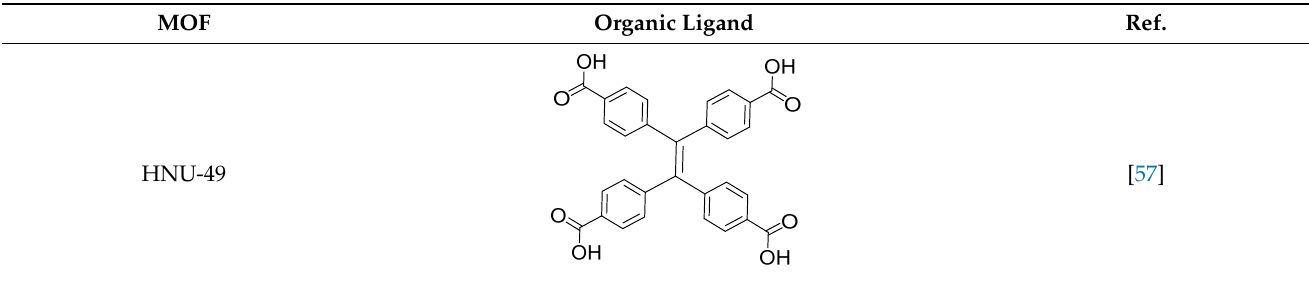
Table 1. Cont. Organic Ligand